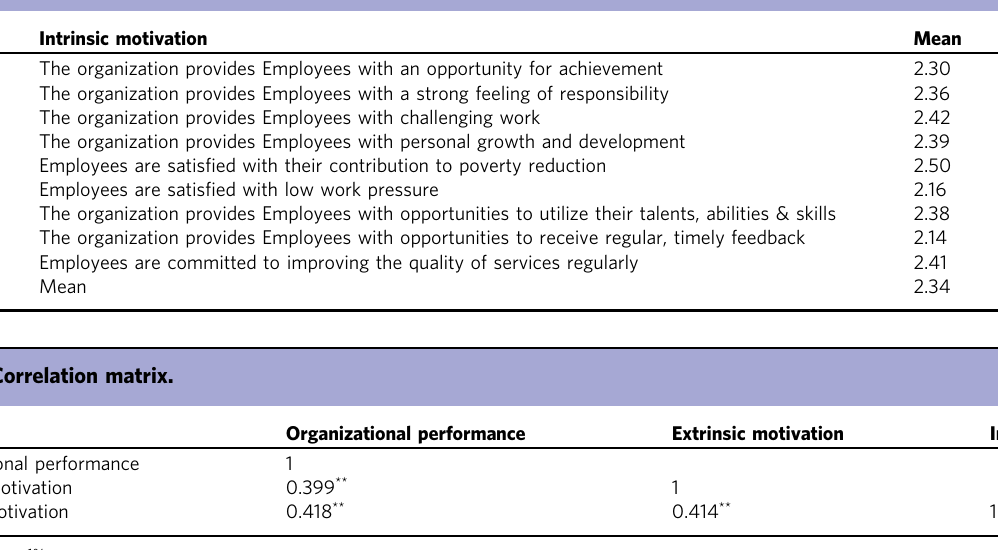
Table 3 Respondents view of intrinsic motivation.